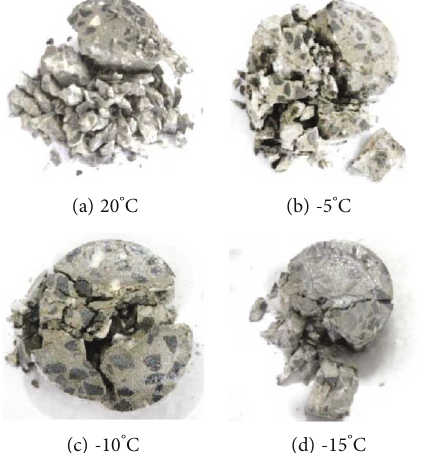
Figure 13: Failure pattern of natural